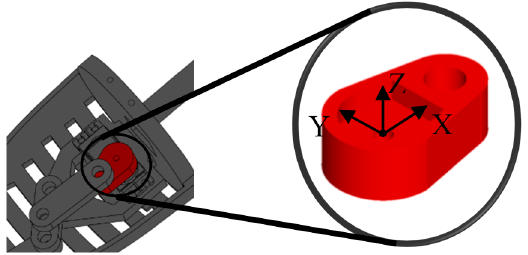
Figure 14. Selection of the manufacturing method to be used.